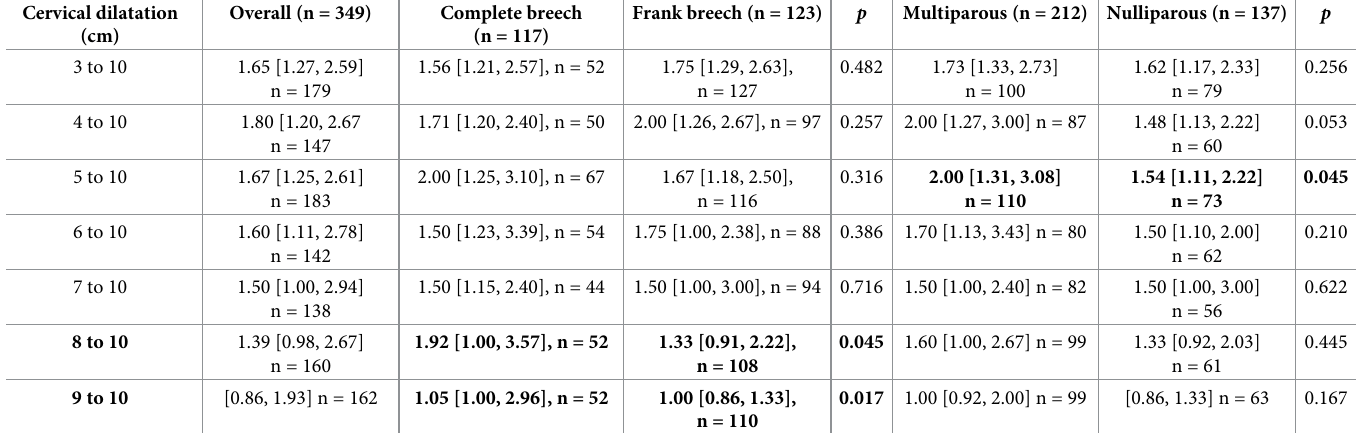
Table 3. Median cervical dilatation rate to the full dilatation (cm/h) for overall and according to type of breech presentation and parity. Results are expressed as median (IQR). Cervical dilatation (cm)